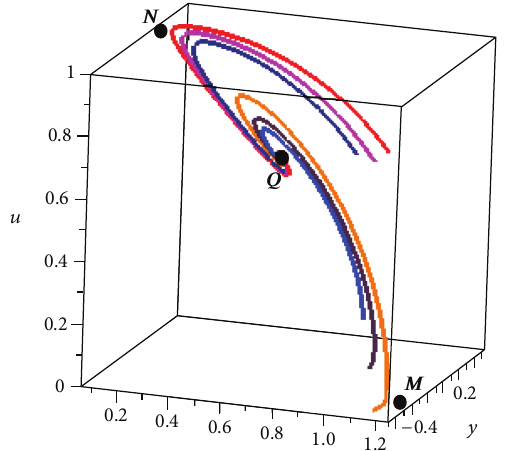
Figure 5: 3-dimensional phase space trajectories of the model with 𝑚 = 1.2 , 𝑛 = 0.7 , 𝛽 = 1 and 𝜔 = 0 . For these values of parameters, the potential energy dominated solution (point M ) is a saddle point, while the point Q (corresponding to the chameleon dominated solution) is a stable attractor solution.